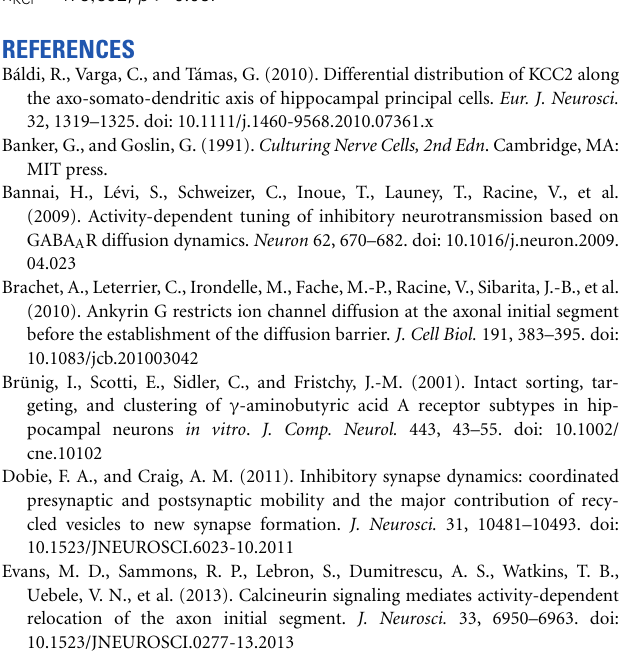
Supplementary Figure 3 | (A) Axon from neuron stained for ankG (top, cyan), γ 2-GABA A Rs (middle, magenta) and VGAT (bottom, yellow), shown merged beneath. Closed arrowheads indicate position of a GABA A R cluster opposed to a VGAT cluster; open arrowheads indicate position of a GABA A R cluster not opposed to a VGAT cluster. ( B) Synaptic GABA A R cluster fraction in axons and dendrites is not significantly different. Axon: